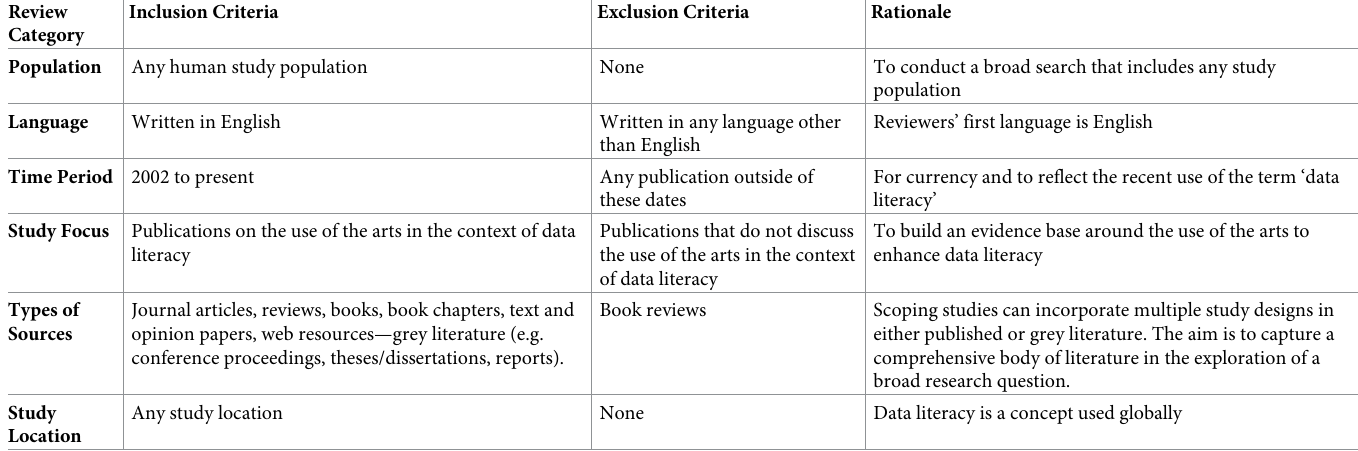
Table 2. Eligibility